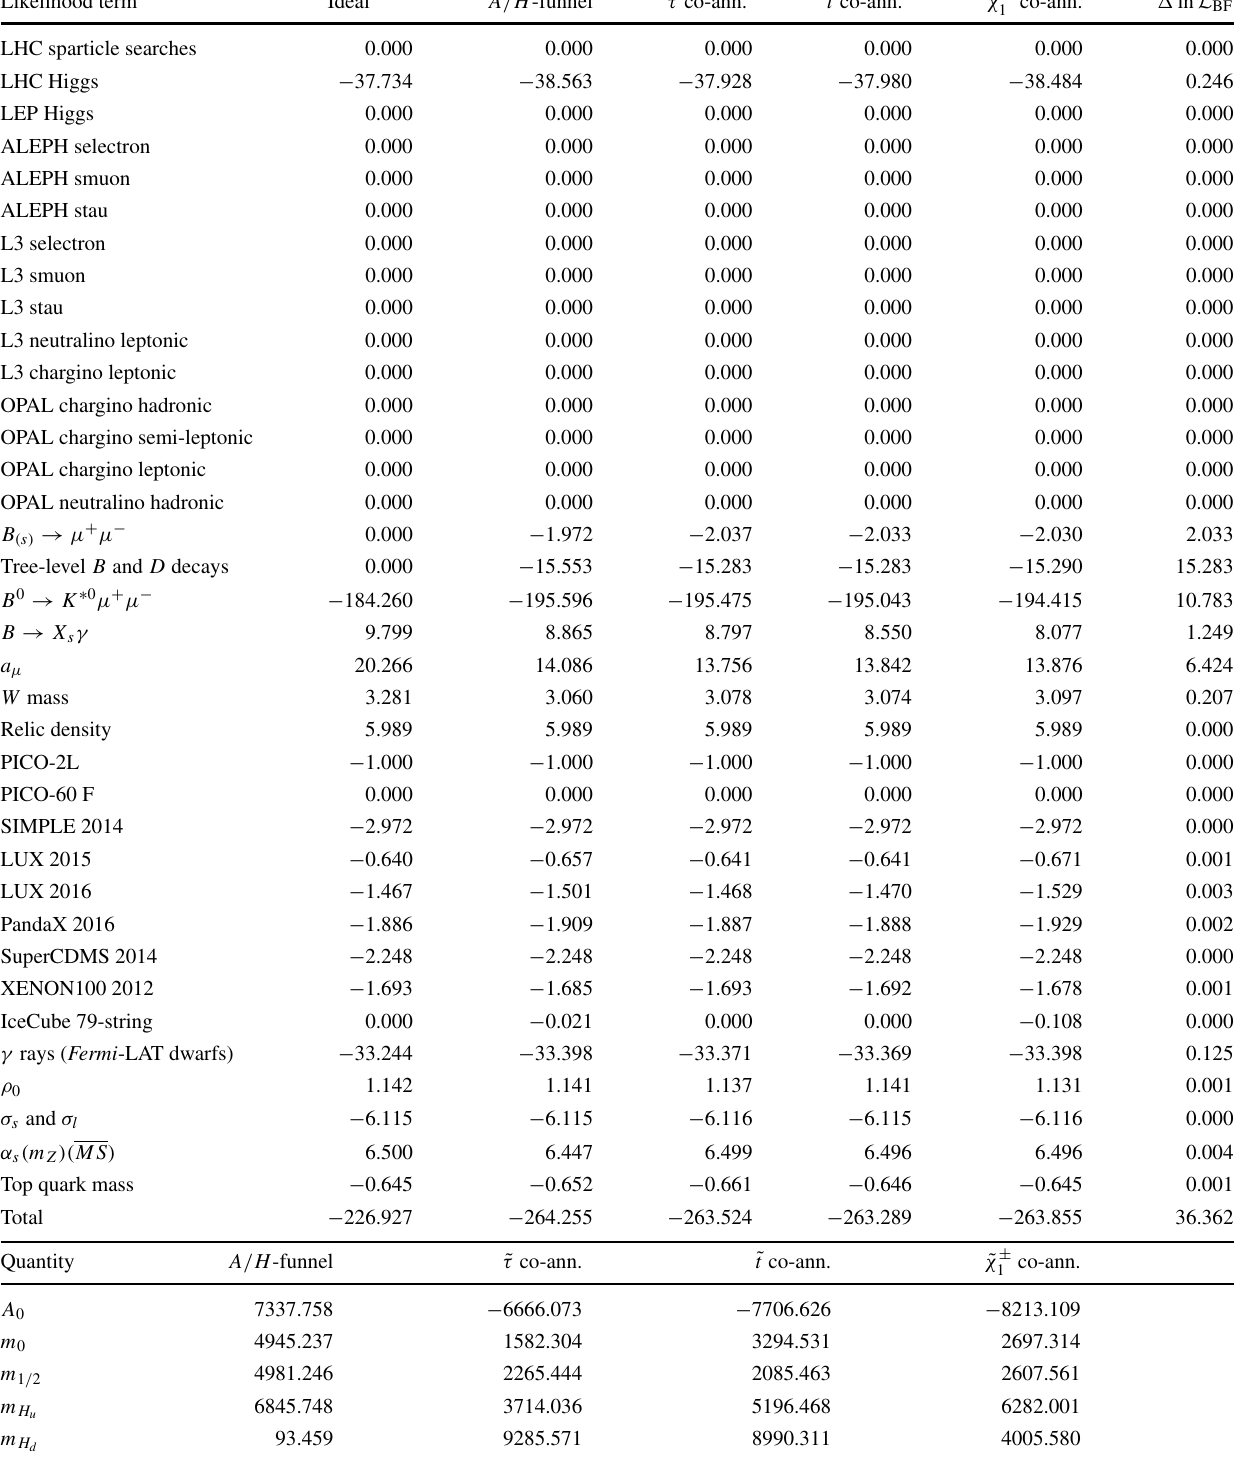
Table 7 Best-fit points in the NUHM2, for each of the regions charac- terised by a specific mechanism for suppressing the relic density of dark matter. Here we show the likelihood contributions, parameter values at each point, and some quantities relevant for the interpretation of mass spectra at the different best fits. We also give likelihood components